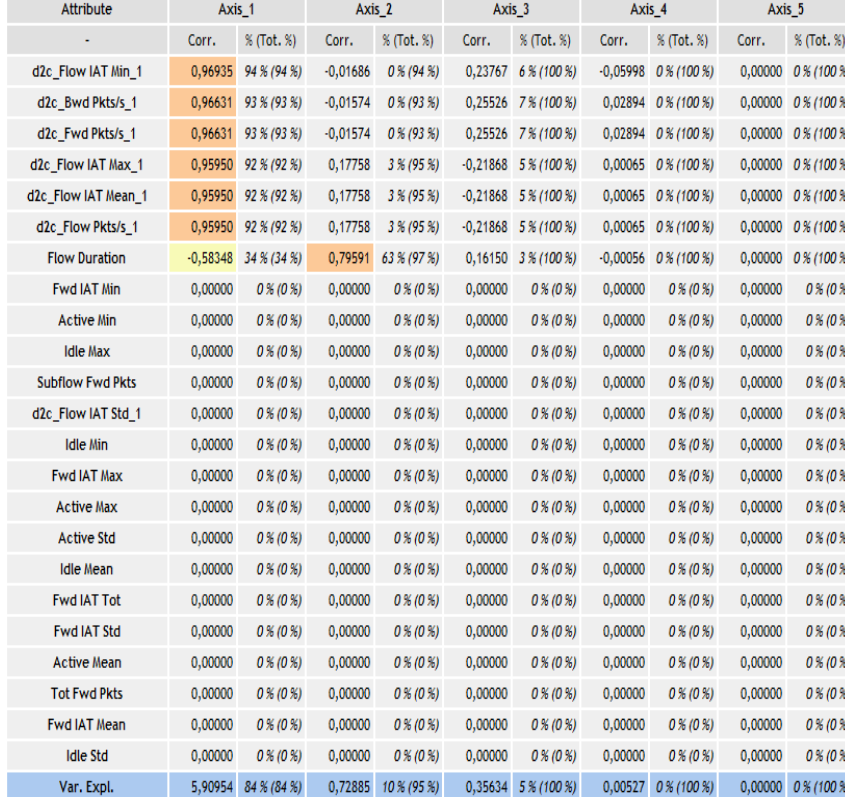
Figure 3. PCA results.